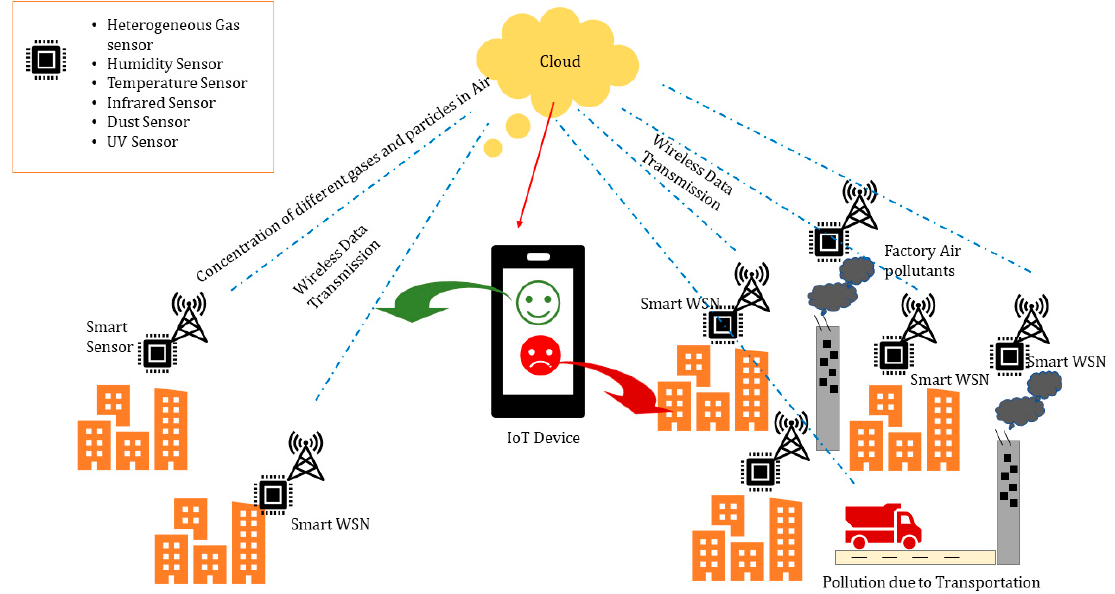
Figure 2. SEM system addressing various issues in the environment using wireless sensor networks (WSNs) and IoT devices.